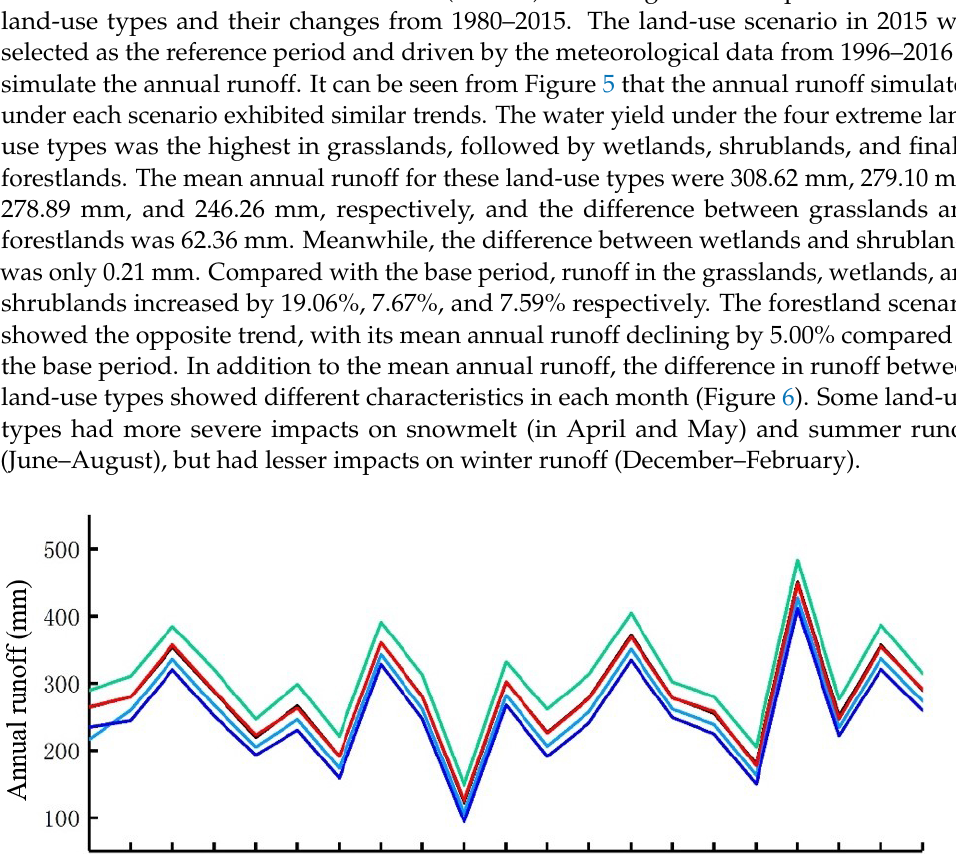
Figure 5. Simulation of annual runoff under extreme land-use scenarios.